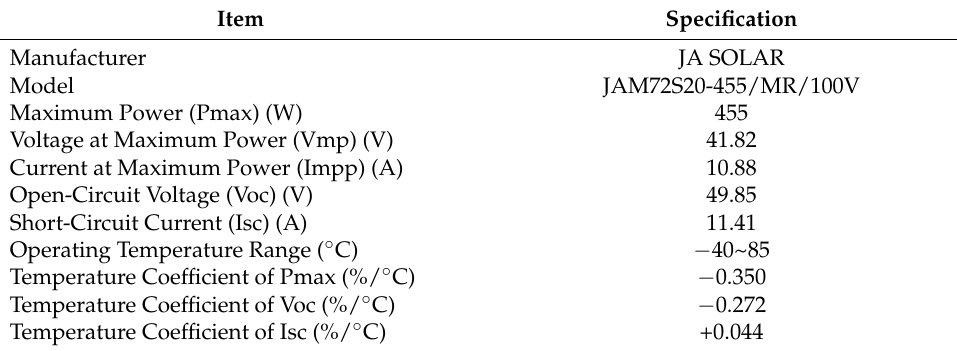
Figure 1. Photovoltaic installation on ESA’s rooftop. Table 1. Specification of the used PV modules under standard test conditions.